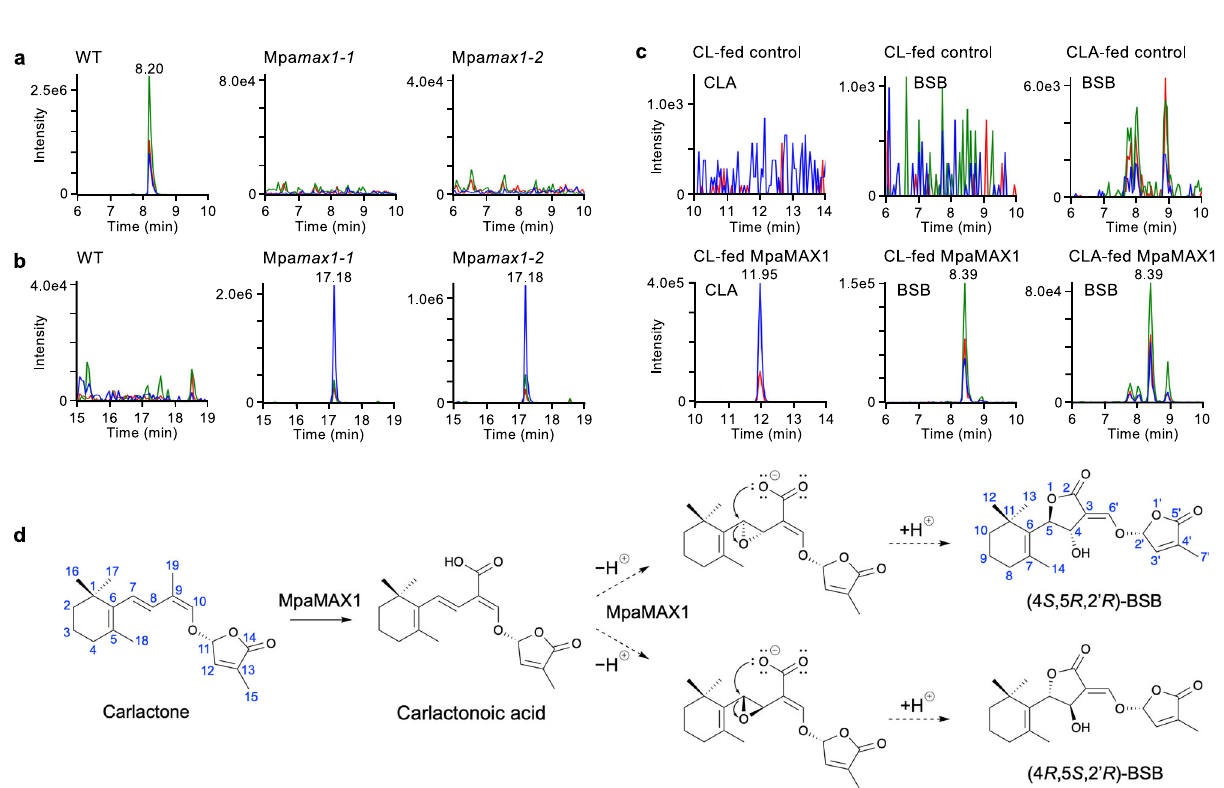
Fig. 3 MpaMAX1 produces BSB from carlactone via carlactonoic acid. a , b Detection of BSB and carlactone in plant tissues of Marchantia . Whole plants of WT and the Mpa max1 mutant (two alleles) were extracted and analyzed by LC-MS/MS. MRM chromatograms of BSB ( a ) and carlactone ( b ) (blue, 303.00/97.00; red, 303.00/189.00; green, 303.00/207.00; m/z in positive mode) are shown. c Detection of carlactonoic acid and BSB in feeding experiments with recombinant MpaMAX1. rac -Carlactone (CL) or rac -carlactonoic acid (CLA) was incubated with the microsomes of MpaMAX1- expressed yeast. Yeast microsomes with an empty vector were used as a control. MRM chromatograms of carlactonoic acid and BSB in extracts of the microsomes are shown. d Proposed mechanism of the conversion to BSB from carlactone. MpaMAX1 oxidizes C-19 to produce carlactonoic acid and catalyzes the α - or β -epoxidation of Δ 7,8, followed by S N 2-type ring opening of the epoxide by the carboxyl oxygen atom to yield the possible two isomers with 4,5-anti-substituted butyrolactone